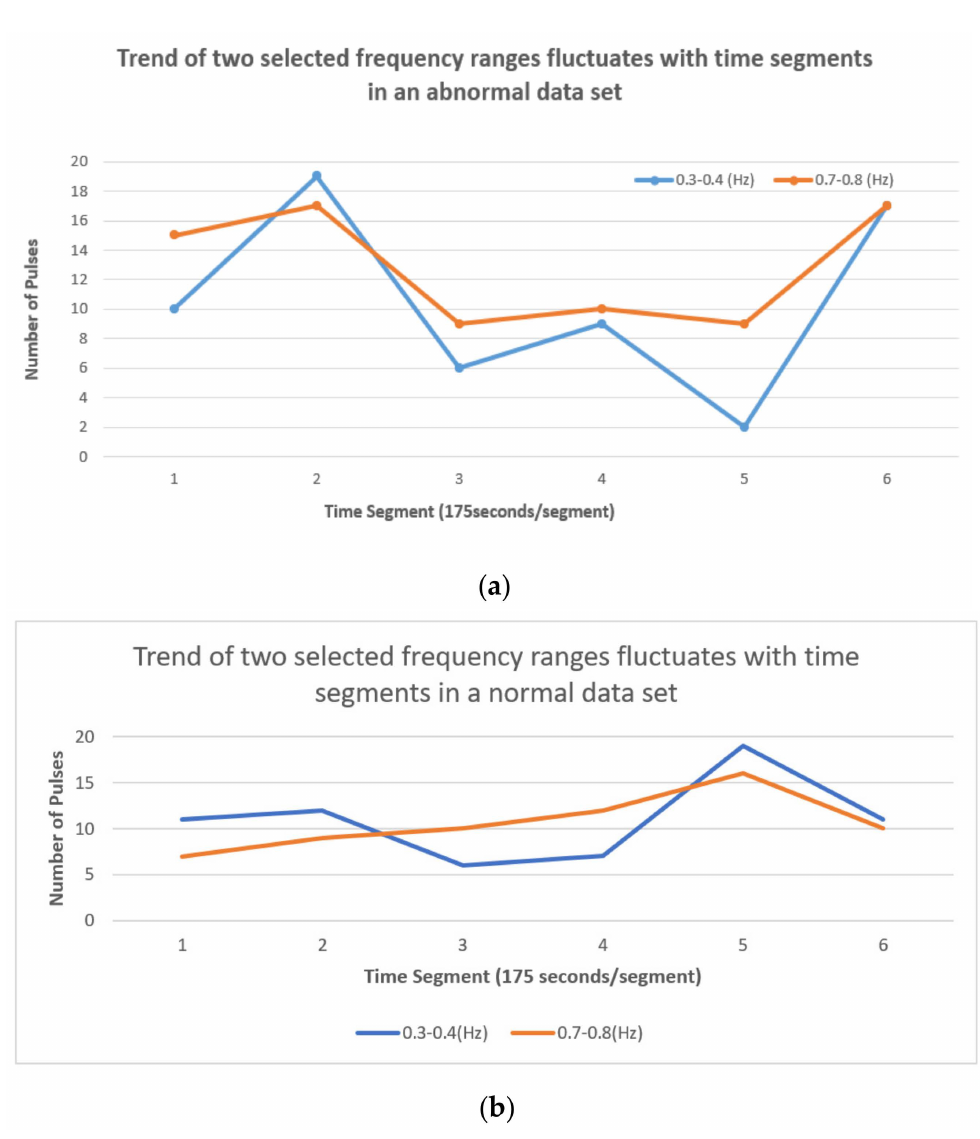
Figure 13. Trend of two selected frequency ranges fluctuates with time segments in another two data sets: ( a ) number of pulses in the two dominant frequency ranges along time segments in an abnormal date set, ( b ) number of pulses in the two dominant frequency ranges along time segments in a normal data